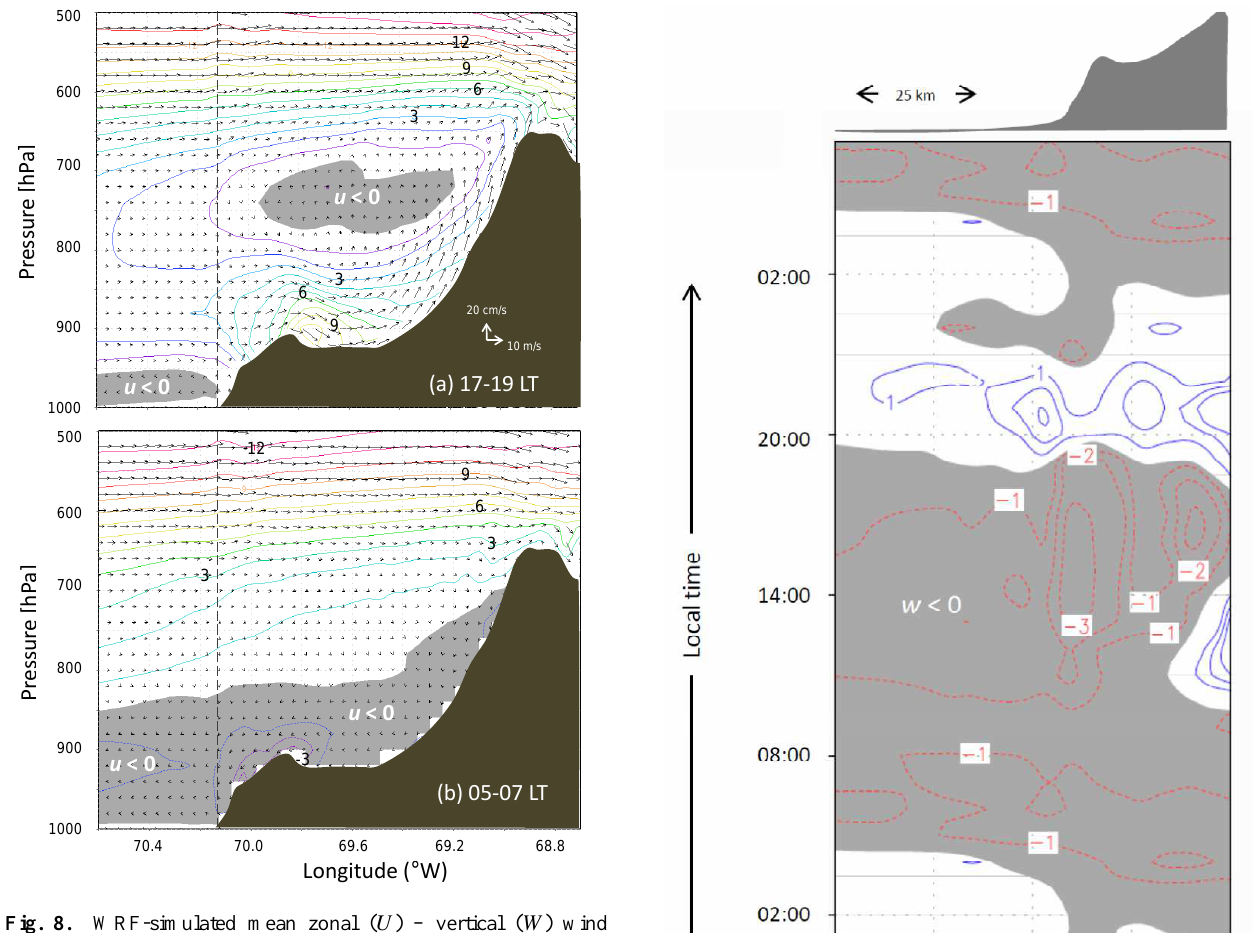
Fig. 8. WRF-simulated mean zonal ( U ) – vertical ( W ) wind vectors (arrows) in an average cross section between 19–22 ◦ S (where main topographic features run approximately north–south; see Fig. 1). Contours are zonal wind speeds: positive (solid) and negative (dashed) for (a) afternoon conditions (17:00–19:00LT) and (b) dawn conditions (05:00–07:00LT). Light gray areas indi- cate easterly flow; dark gray areas mark the topographic profile. The vertical dashed line represents the selected longitude for verti- cal profiles (column P ) used later in Fig. 10.